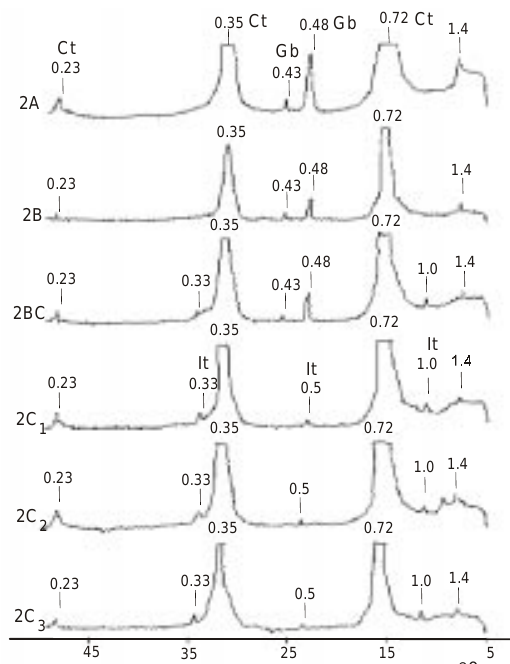
Figura 2. Difratogramas de raios-X da fração argila desferrificada para o perfil 1 – PVAd (espaça- mento d em nm) (Ct = caulinita, Gb = gibbsita e It = illita).